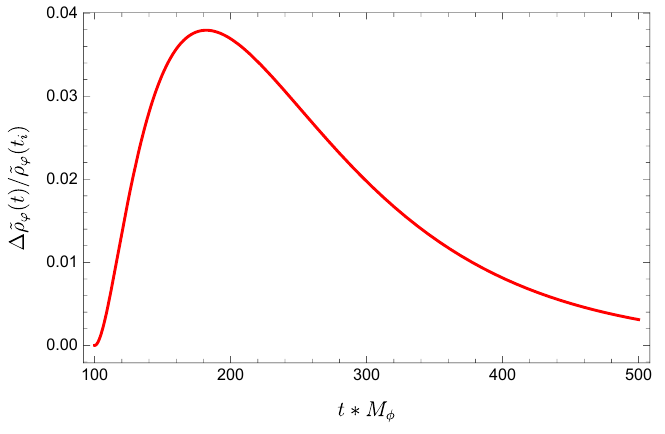
Figure 8 . The difference between the comoving energy density of the condensate in a radiation- dominated universe and the energy density of the condensate in a static